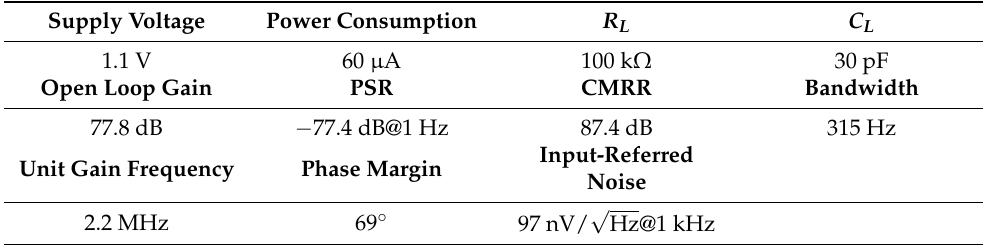
Table 4. Performance summary of the DDA.